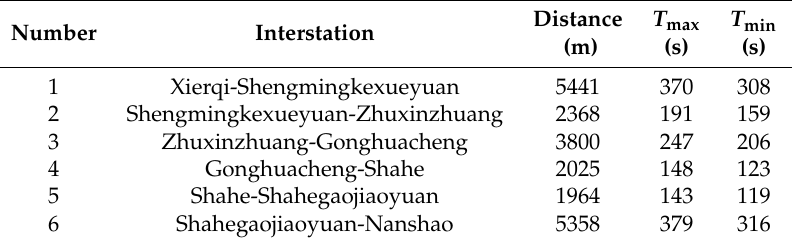
Figure 7. Beijing Changping subway line. Table 5. Operation requirements of the Changping line.